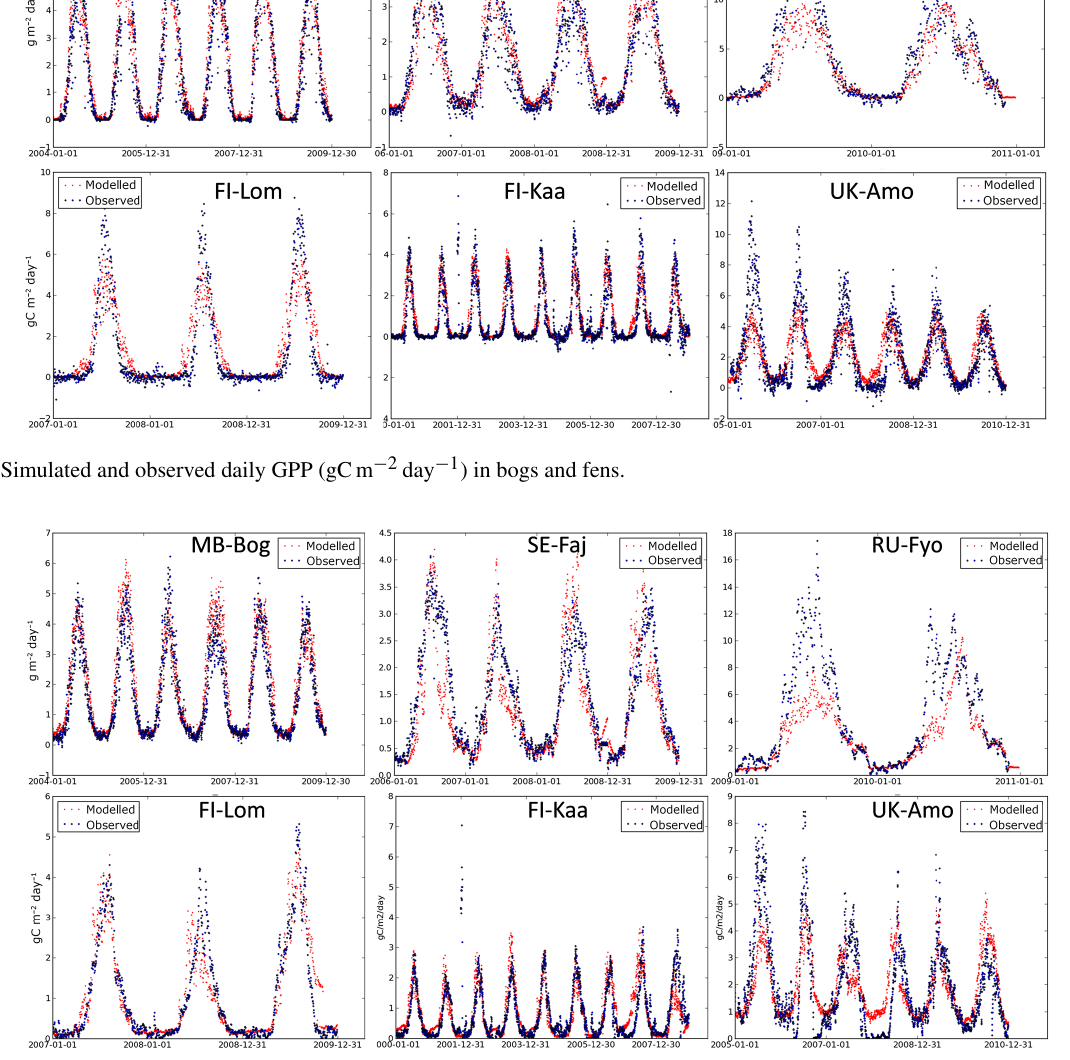
ulated HR, whereas sites such as SE-Faj and FI-Lom